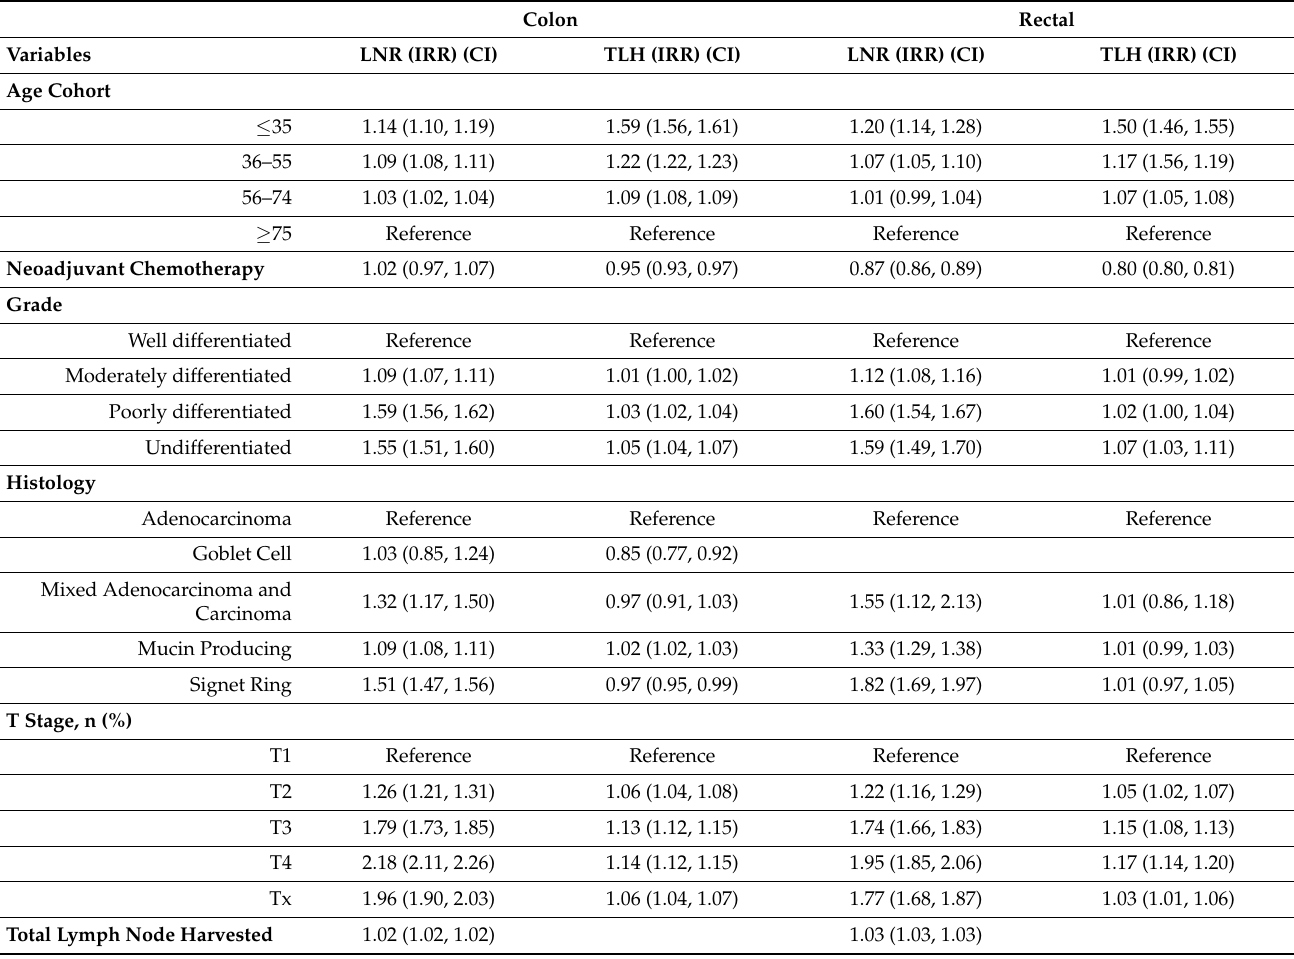
Table 4. Negative binomial regression, TLH and LNR colon vs. rectal cancer. Colon